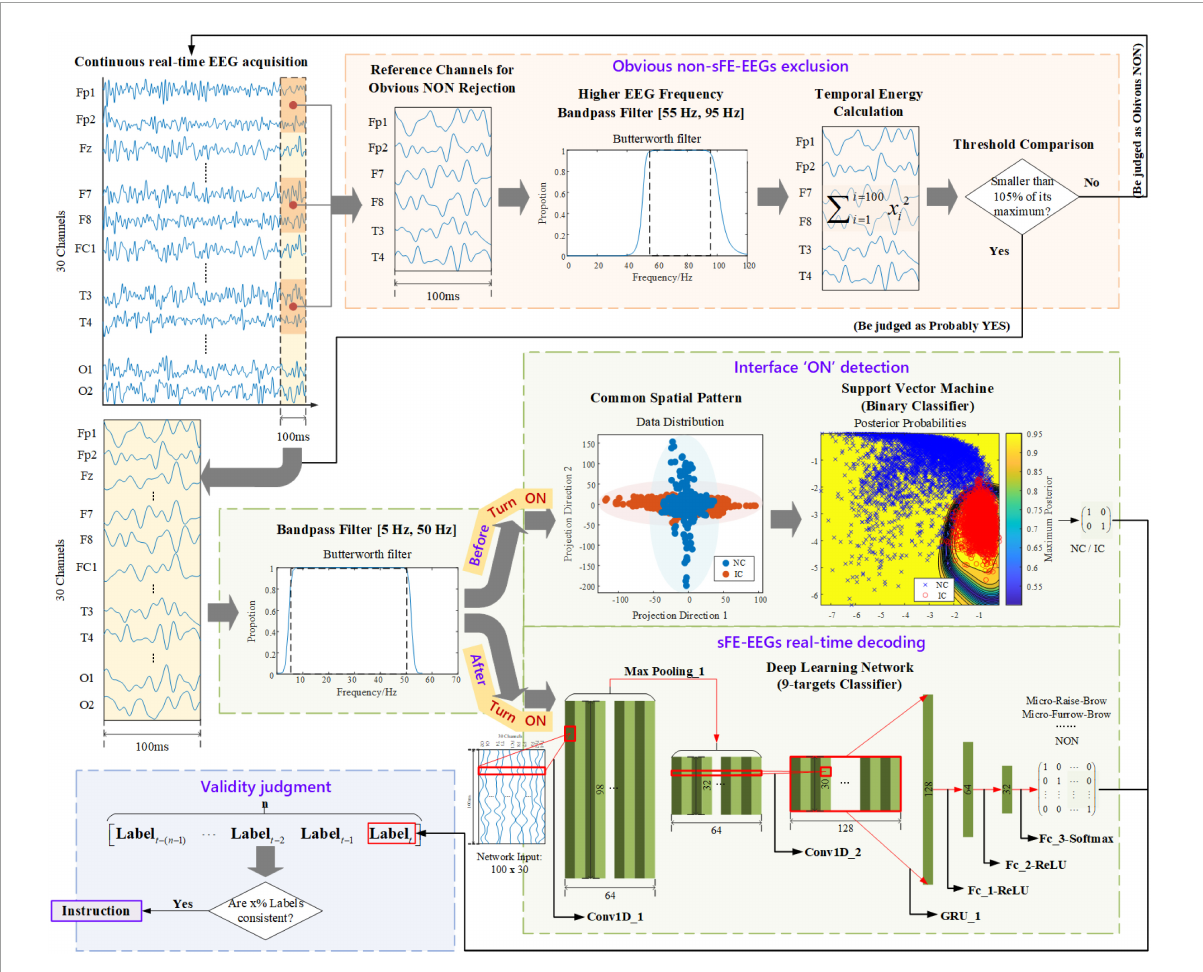
FIGURE5 The detailed algorithm of slight-facial